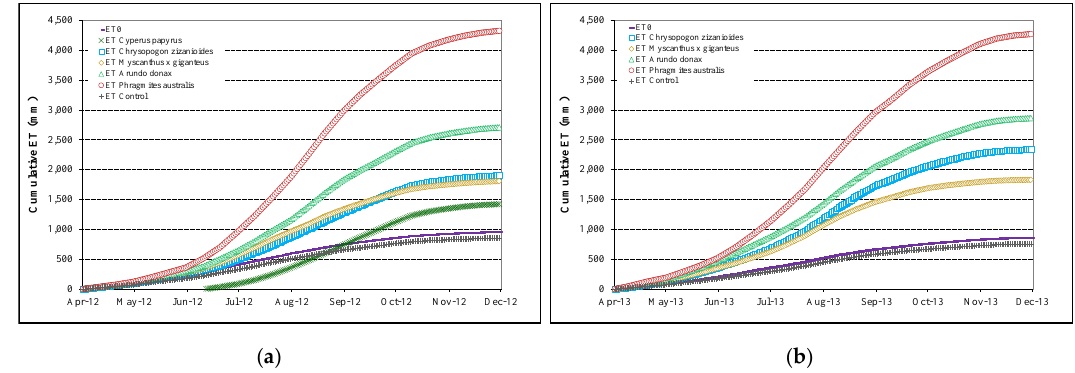
Figure 7. Cumulative ET 0 , ET con , and ET for C. papyrus , C. zizanioides , M. giganteus , A. donax , and P. australis during 2012 ( a ) and 2013 ( b ) observation periods.